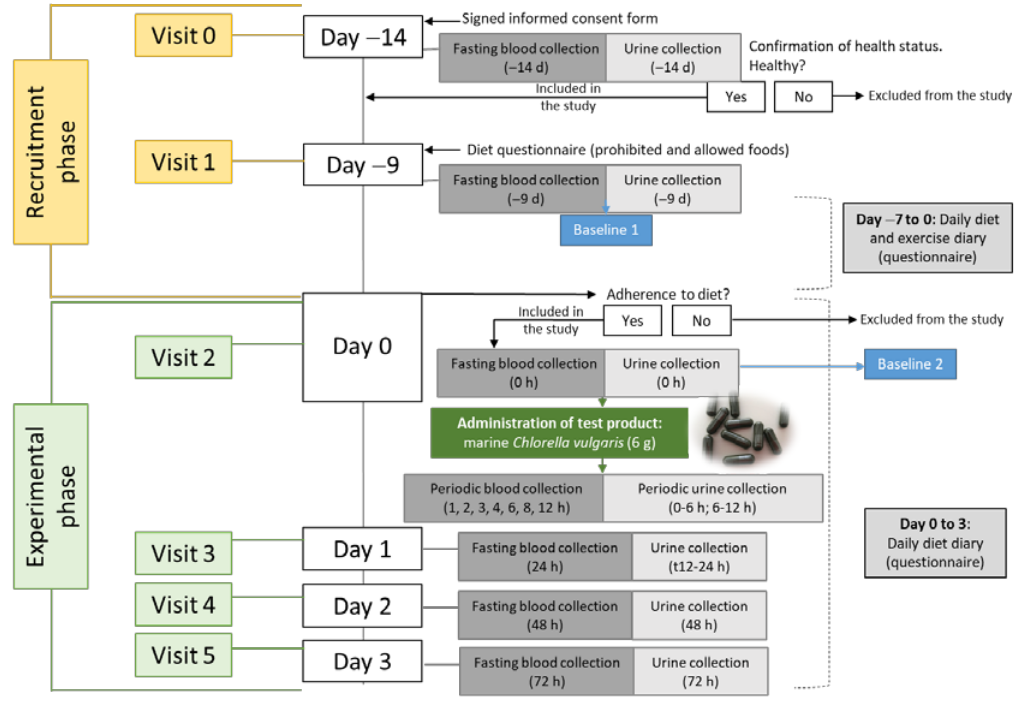
Figure 1. Diagram of the study.